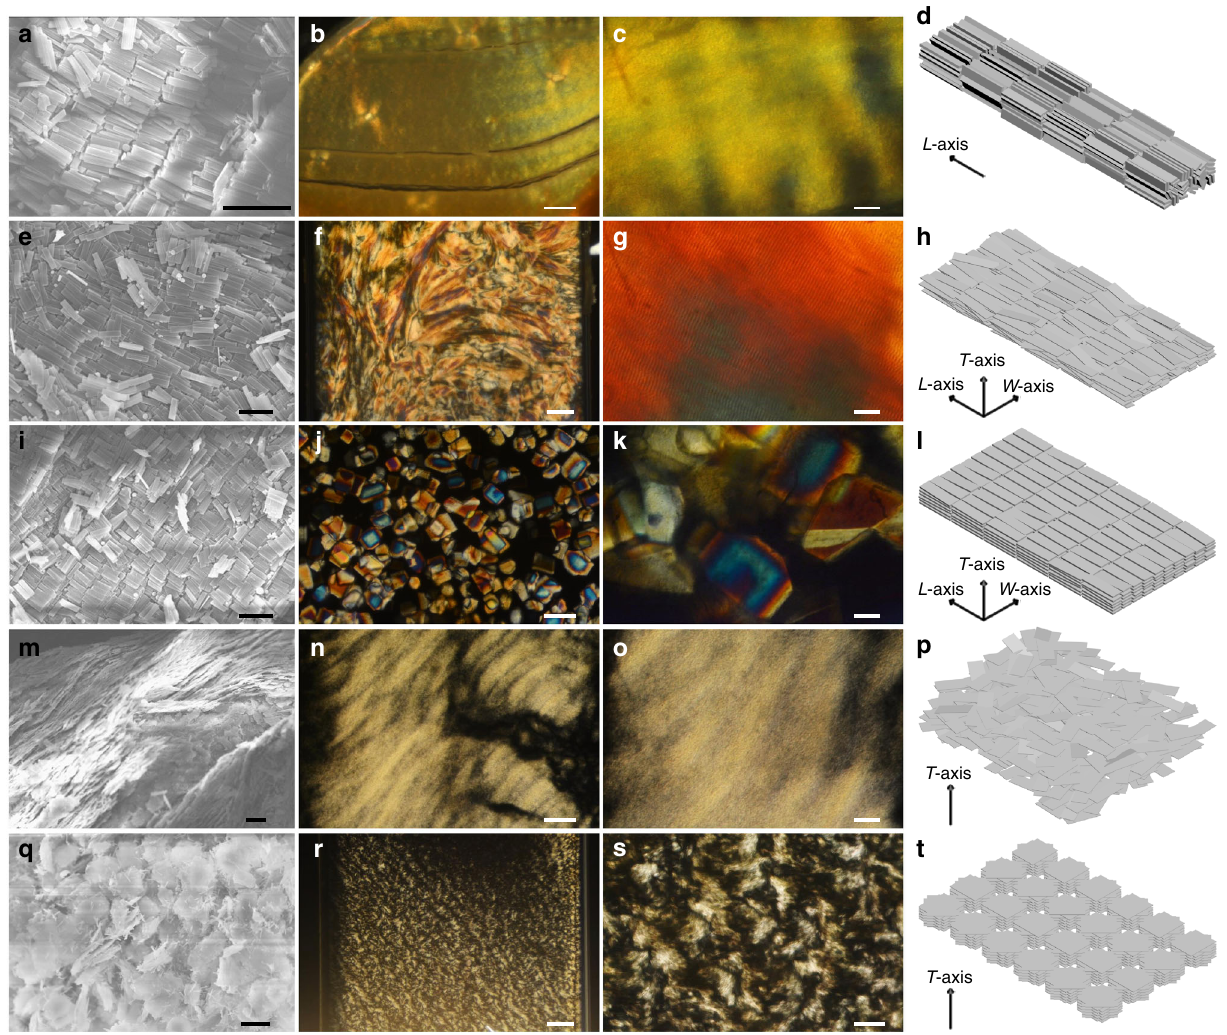
Fig. 4 LC phases of cuboidal colloids with different geometries. Representative ( a , e , i , m , q ) SEM images, corresponding large-area ( b , f , j , n , r ) and enlarged ( c , g , k , o , s ) POM images, and schematic illustrations ( d , h , l , p , t ) of LC phases assembled from different cuboidal colloids in planar capillary: SmAu phase, cuboids of L = 2350 nm, W = 360 nm, T = 125 nm ( a – d ), SmAb phase, cuboids of L = 3270 nm, W = 830 nm, T = 78 nm ( e – h ), crystal B phase, cuboids of L = 2640 nm, W = 750 nm, T = 100 nm ( i – l ), N − phase, cuboids of L = 4080 nm, W = 1530 nm, T = 70 nm ( m – p ), Col phase, cuboids of L = 3720 nm, W = 3040 nm, T = 70 nm ( q – t ). Scale bars, 5 μ m in ( a , e , i , m , q ), 100 μ m in ( b , j , n ), 200 μ m in ( f , r ), 20 μ m in ( c , g , k , o ), and 50 μ m in ( s